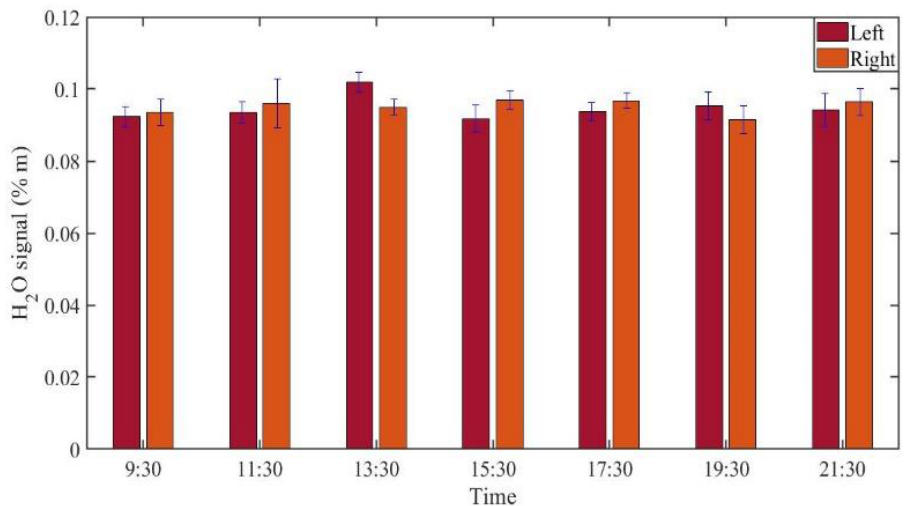
Figure 12. The changes of measured water vapor signal from a frontal sinus of the healthy volunteer 1 during one day.